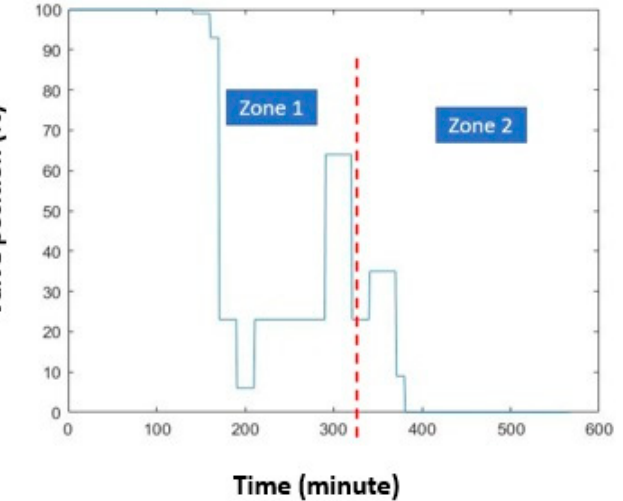
Figure 22. Valve position fluctuations in a practical classroom (measured values). Zone: It remarks different conditions during the experiments.